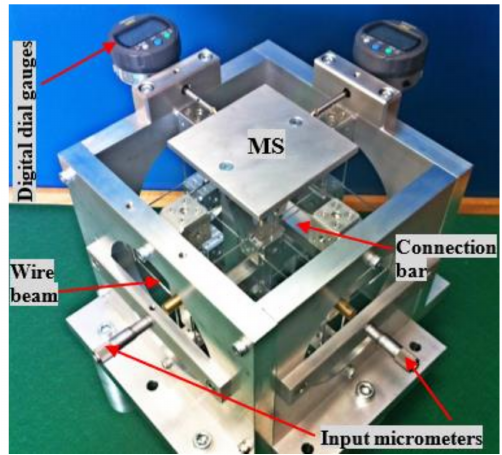
Figure 15. A prototype of the practical design.